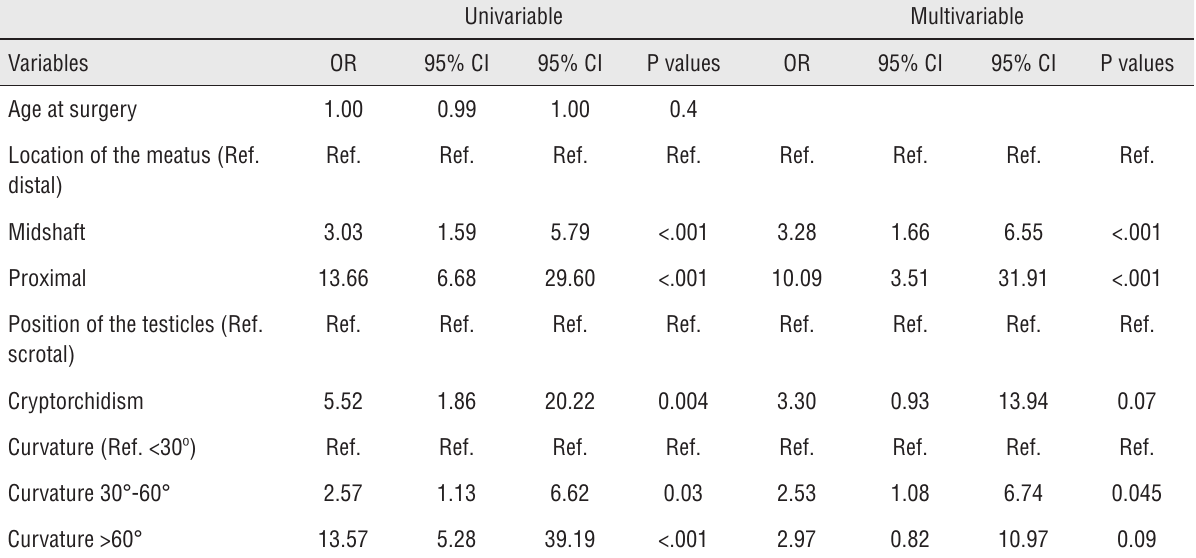
Table 2 - Univariable and Multivariable logistic regression models testing for predictors of pubic hypertrophy within 266 patients treated for